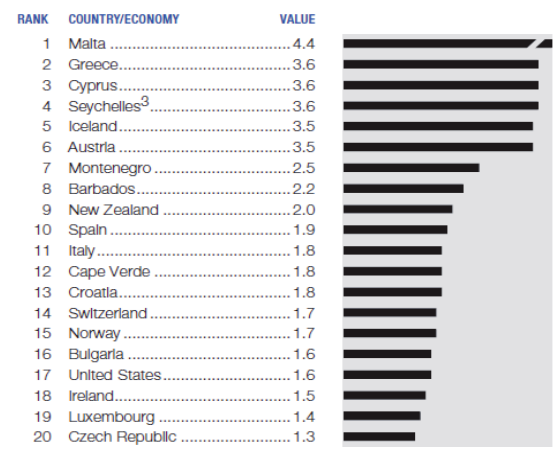
Fig.3 WEF TTCI, 12. Pilar - Tourist Service Infrastructure 12.01 Hotel Rooms Source: WEF TTCI 2005 (p.